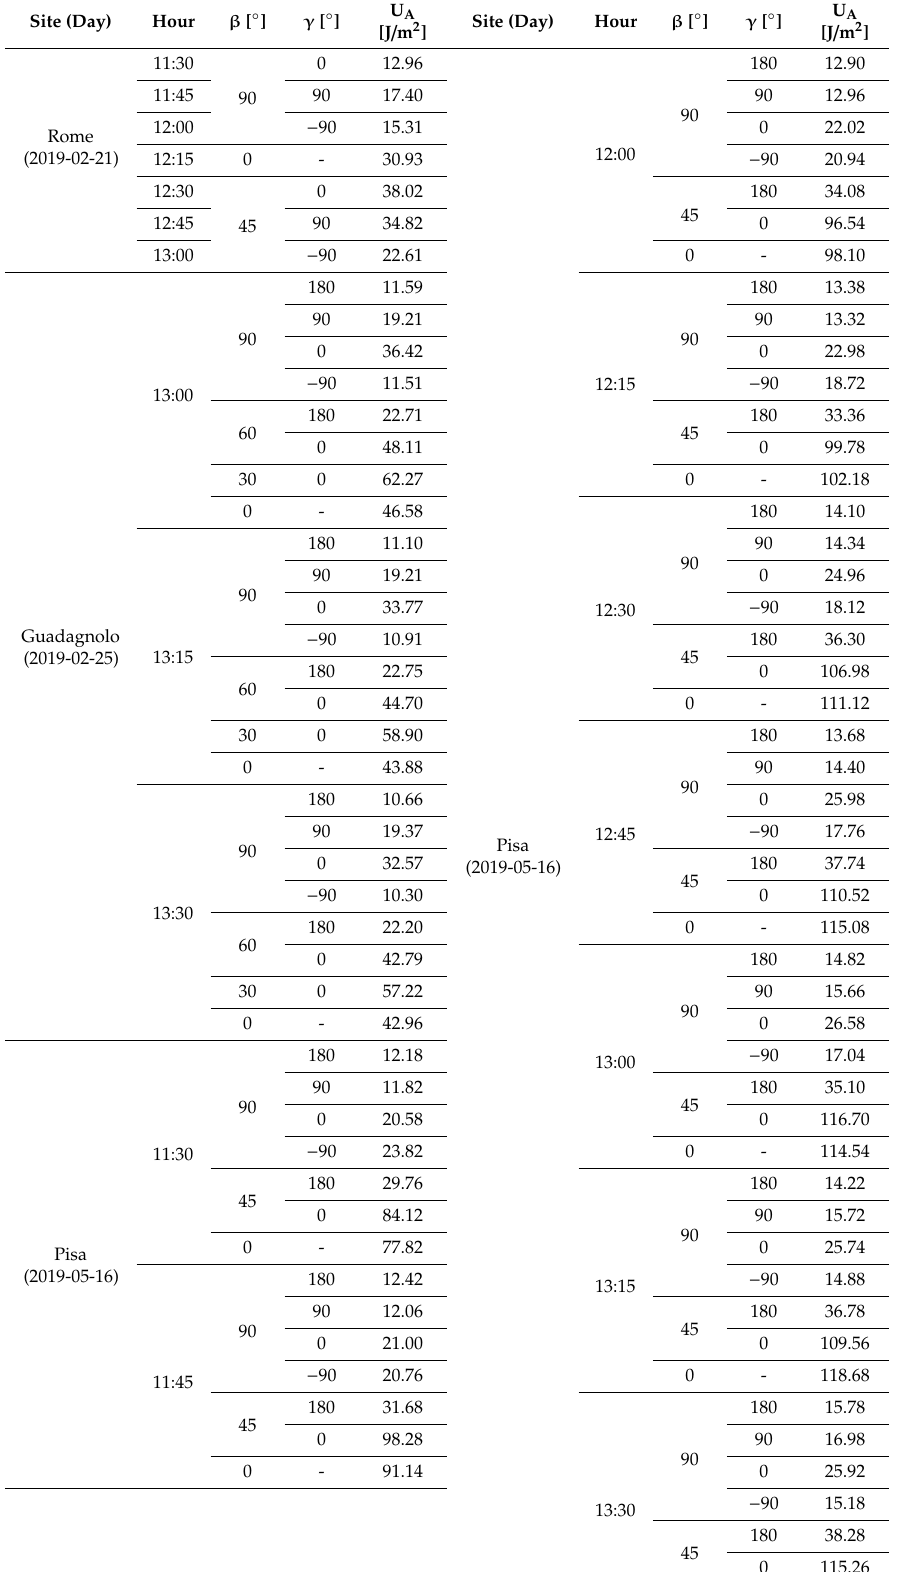
Table 7. U A values obtained from the measurement activity in the three considered sites for horizontal and sloped surfaces facing the four cardinal